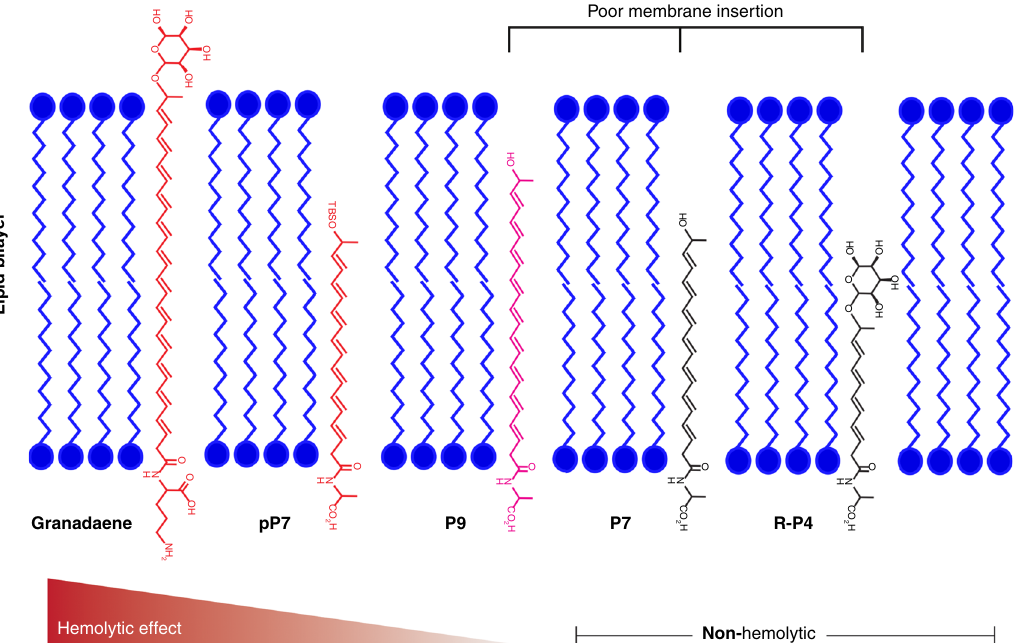
Fig. 2 Proposed role of polyenes and polar head groups for granadaene-mediated hemolysis and cytolysis. The polyene chain of granadaene spans the length of the target cell ’ s lipid bilayer and the two polar head groups, rhamnose and ornithine, allow for stable insertion of the GBS ornithine rhamnopolyene into the cell membrane, leading to membrane disruption and hemolysis or cytolysis. Shorter polyenes such as those containing seven double bonds are hemolytic only when one polar end is replaced with a hydrophobic group (e.g., TBS), as in pP7 , in which the molecule stably inserts in the membrane due to the compatibility between the hydrophobic lipid bilayer and the TBS group. However, if both polar ends are maintained in compounds with shorter polyenes, as in P7 or R-P4 , no hemolytic activity is observed because stable insertion into the cell membrane is not favored. Once the polyene chain reaches a suf fi cient length, as in P9 , some hemolytic activity is observed even when both polar head groups are maintained. Together, this suggests that the length of the polyene chain and polar head groups found in granadaene are key to stable membrane disruption of host granadaene were viable (DAPI − ) (Supplementary Fig. 3), so this group was excluded from the CD69 analysis in both cell types.